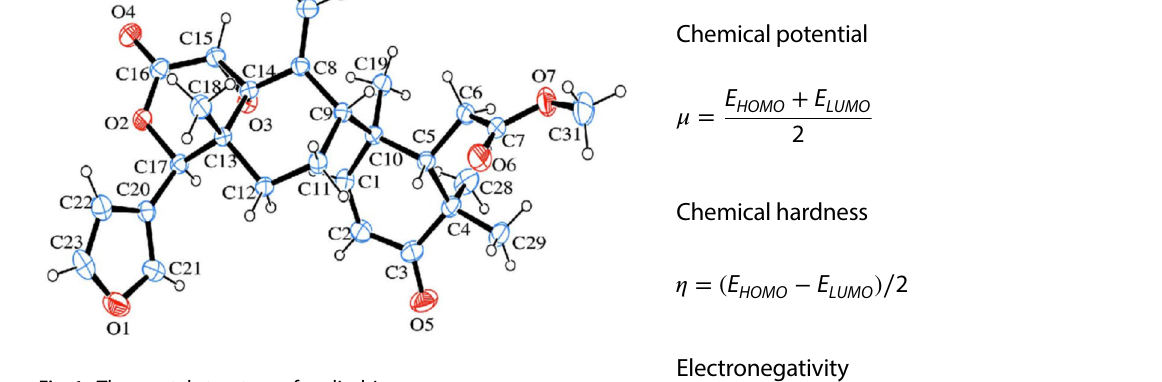
Fig. 1 The crystal structure of